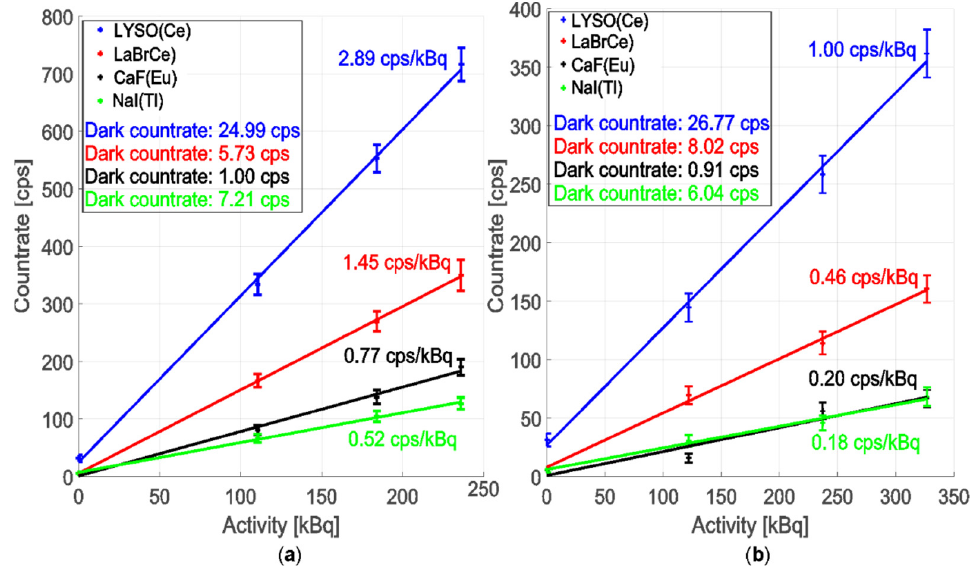
Figure 8. Dosimeter measurement sensitivity comparison with the scintillation crystal coupling to FP1500URT optical fibre with 1.5 mm optical core diameter and 1 m length. ( a ) The ionising radiation sources: ID1–ID3. ( b ) The ionising radiation sources: ID4–ID6.